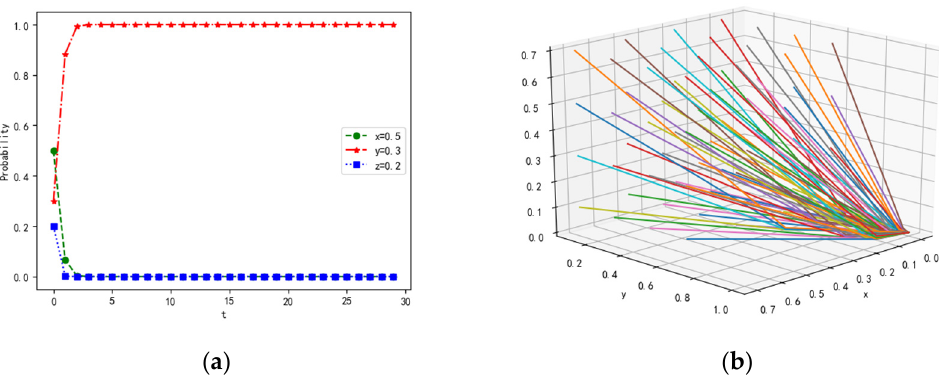
Figure 7. Evolutionary results of p 6 ( 0,1,0 ) shown under a corresponding constraint condition, ( a ) represents the conver- gence of probability with time, and ( b ) shows the results of dynamic simulation in three dimensions.